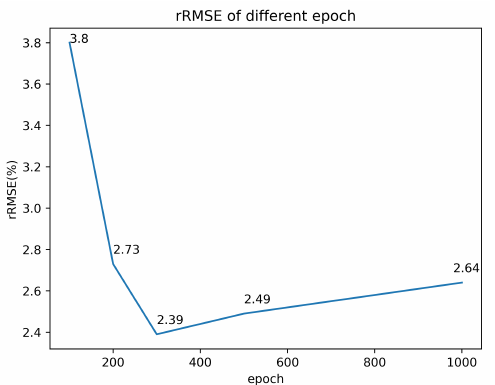
Figure 11. Effect of different epoches on model prediction effectiveness.